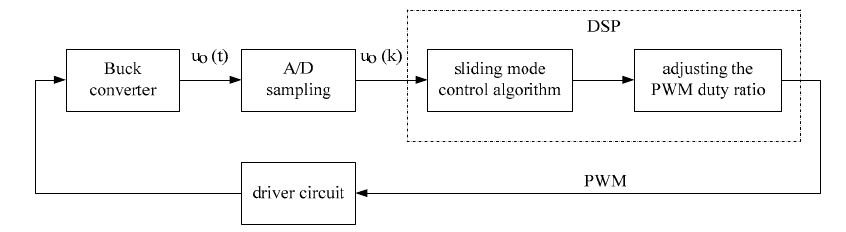
Figure 9. The block diagram of the experimental platform.